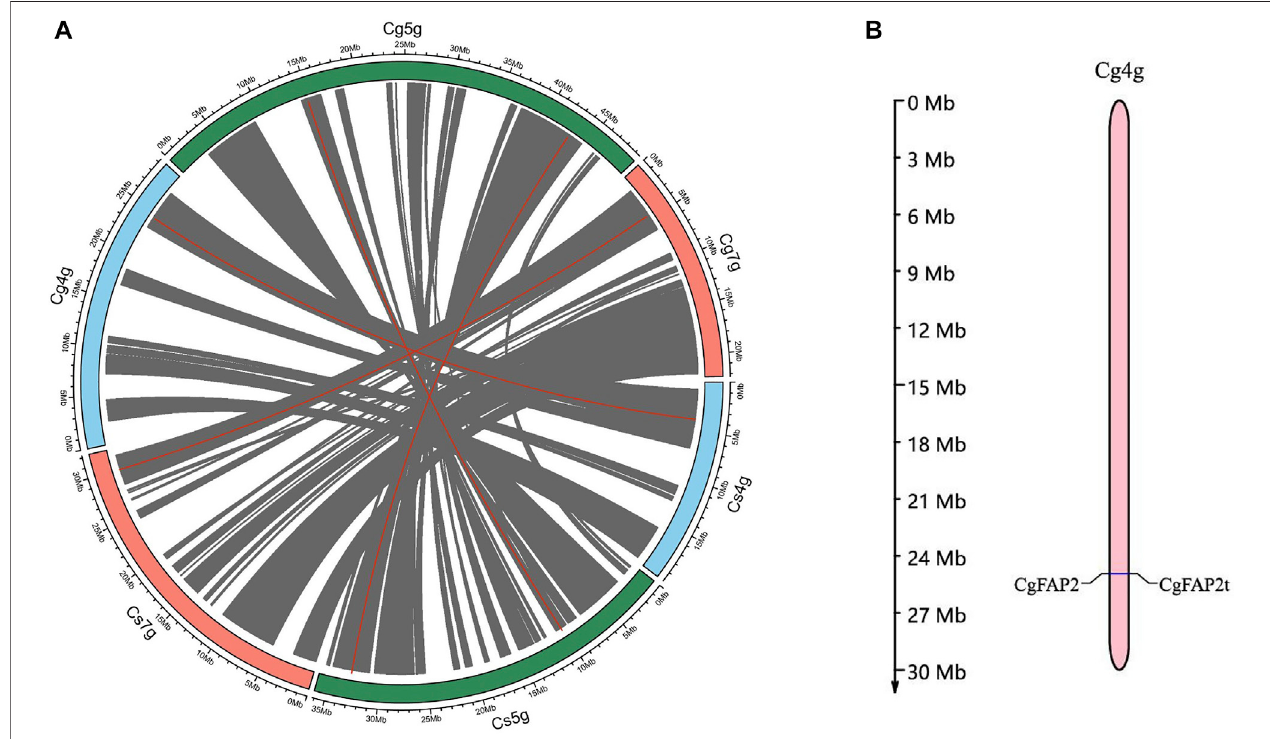
FIGURE3| Syntenic analyses of CHI genesin C.grandis and C.sinensis . (A) Collineargenesof C.grandis and C.sinensis .Greylines represent all collineargenes, red lines represent CHI genesbetween C. grandis and C. sinensis . (B) Tandem genes of C. grandis CgFAP2 genes. Expression pattern analysis ofCHI genes during the fruit